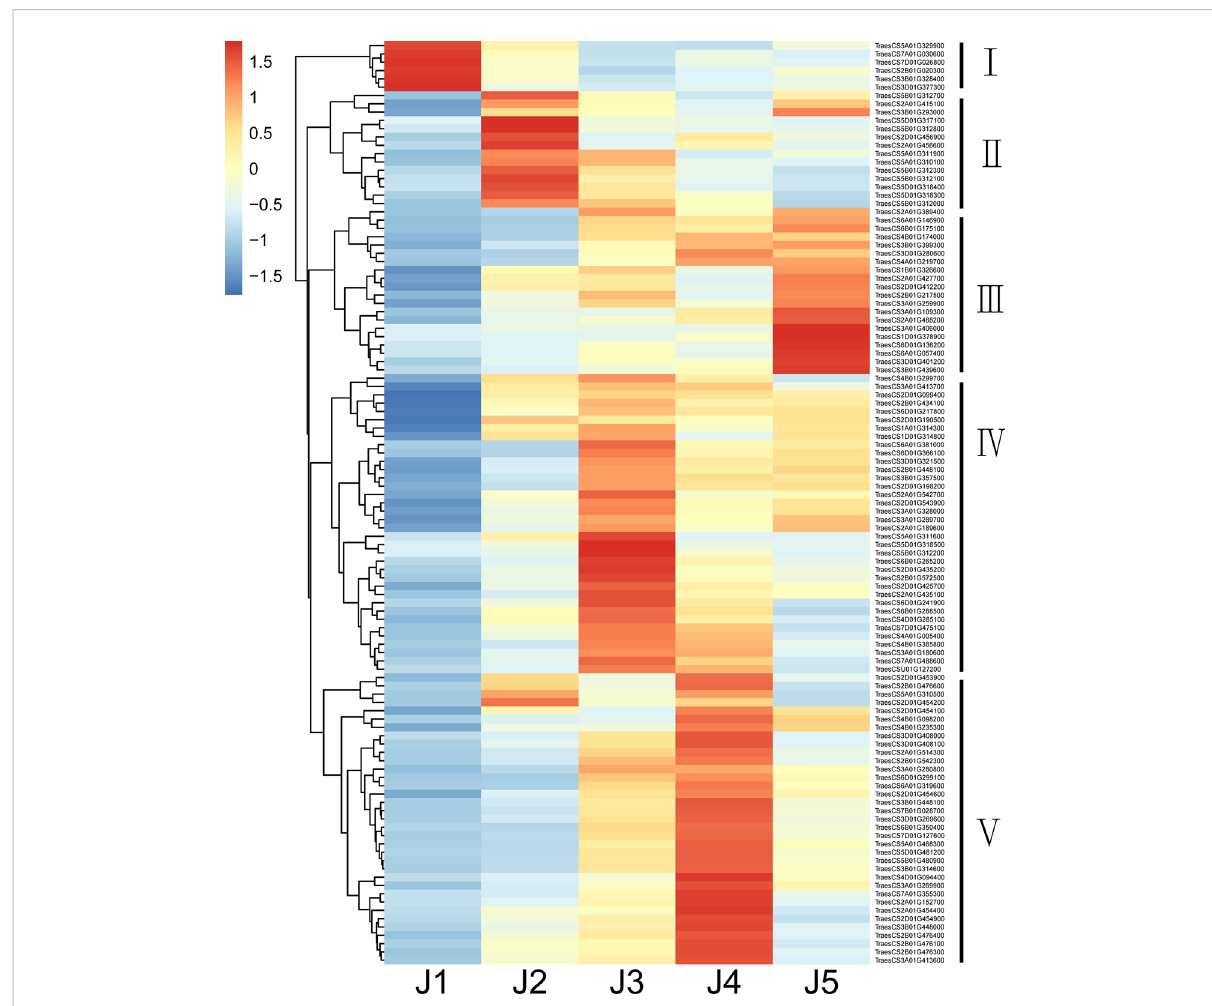
FIGURE 4 A heat map Showing the expression pattern of differentially expressed TF genes under freezing stress at different time points. Columns and rows in the heat map respectively represent the fi ve time points of freezing treatment and common differentially expressed TFs. Color bars represent scaled FPKM of each TF